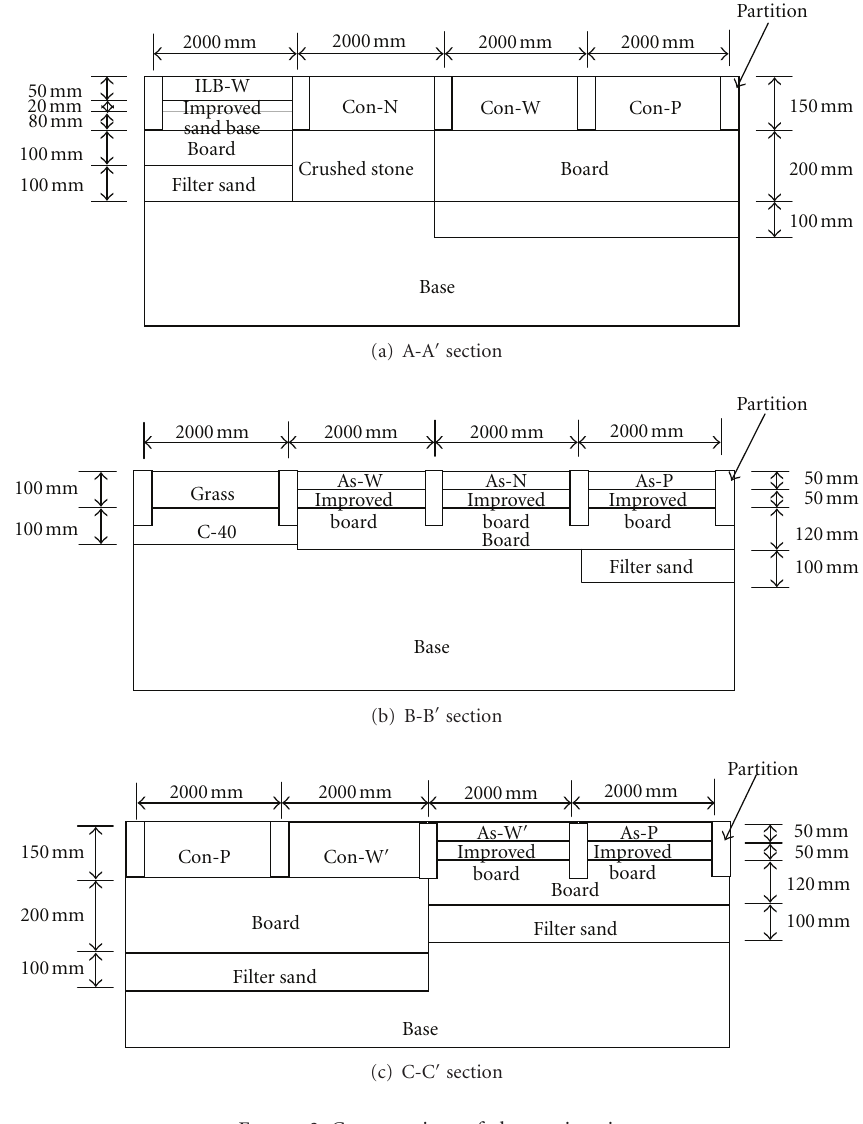
Figure 3: Cross-sections of observation site.